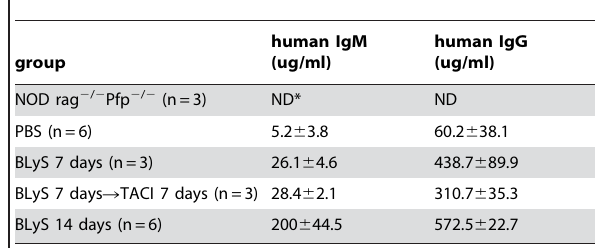
Table 3. Human serum Ig.